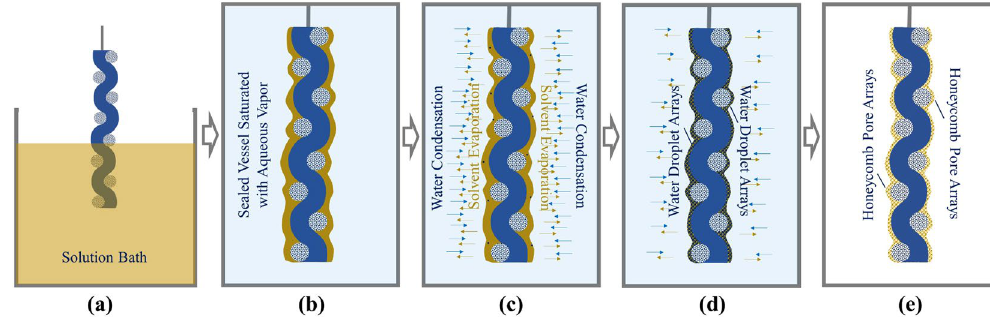
Figure 5. Schematic processes of preparing CPMFs via BFs, ( a ) introducing polymer solution onto fabric by dip coating, ( b ) transferring solution-coated fabric into a sealed vessel saturated with aqueous vapor quickly, ( c ) Condensing water onto the solution-coated fabric by evaporative cooling, ( d ) Retaining conformal water droplet arrays-containing polymer gels on fabric, and ( e ) Obtaining CPMFs after complete evaporation of water and solvent.